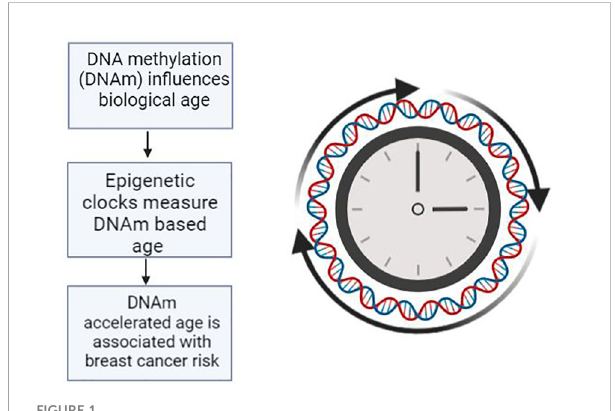
FIGURE 1 Breast Cancer riskis in fl uenced by biological age measured by epigenetic